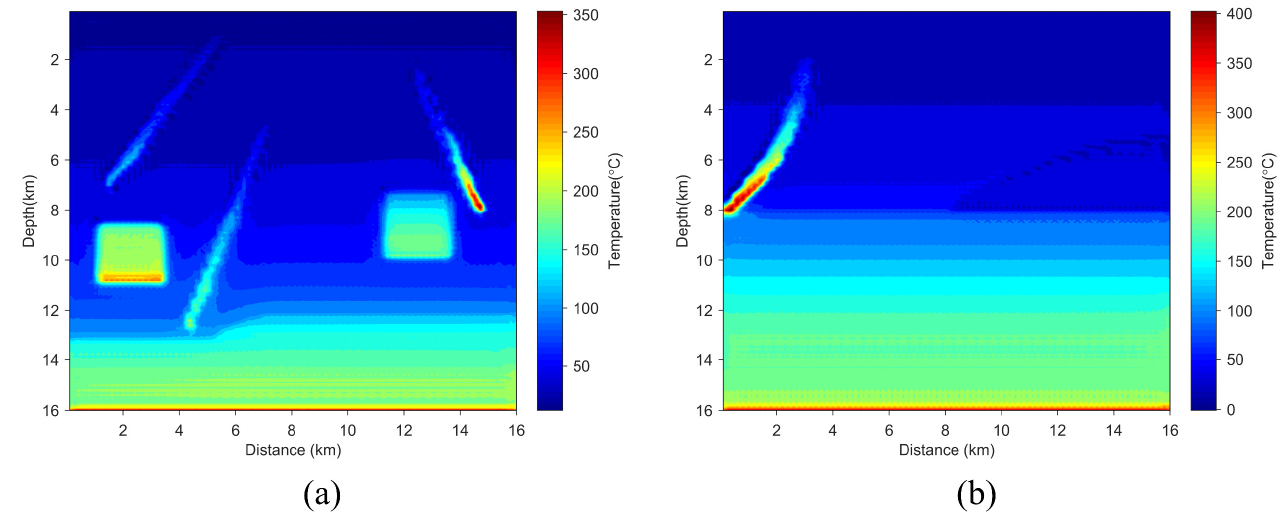
Figure 15. Temperature field simulated from HDRT–UNet (excluding the heat conduction channels). ( a ) temperature field of model a simulated from HDRT–UNet; ( b ) temperature field of model b simulated from HDRT–UNet. Table 2. Time used to simulate temperature